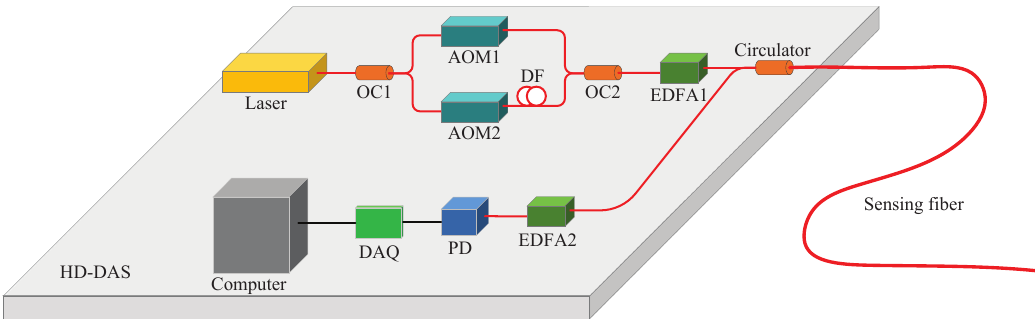
Figure 2. Experimental configuration of HD-DAS system. OC, optical coupler; AOM, acousto-optic modulator; DF, delay fiber; EDFA, Erbium-doped fiber amplifier; PD, photo detector; DAQ, data